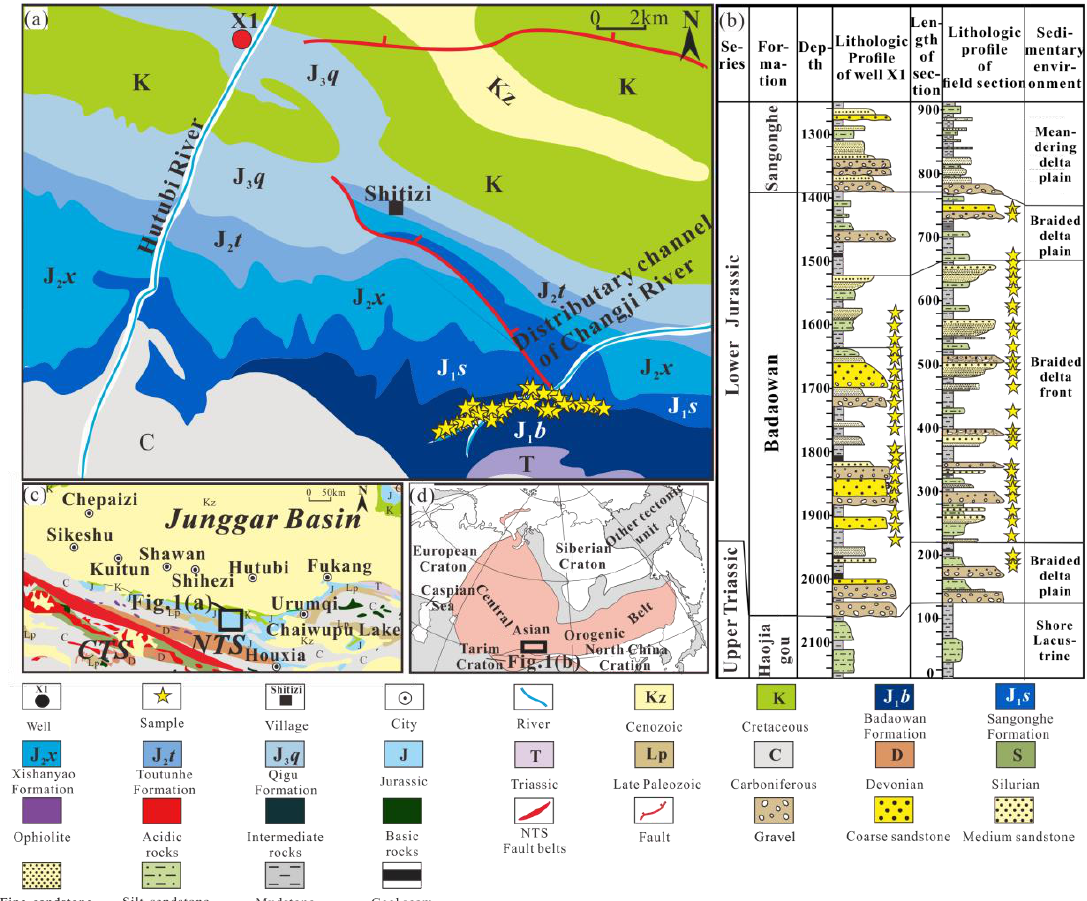
Figure 1. ( a ) Location of the study area, sampled well, and field section; ( b ) the stratigraphic column of the Badaowan Formation; ( c ) geological map of the southern Junggar Basin and the location of the study area; and ( d ) location of the Central Asian Orogenic Belt (modified by [38]).